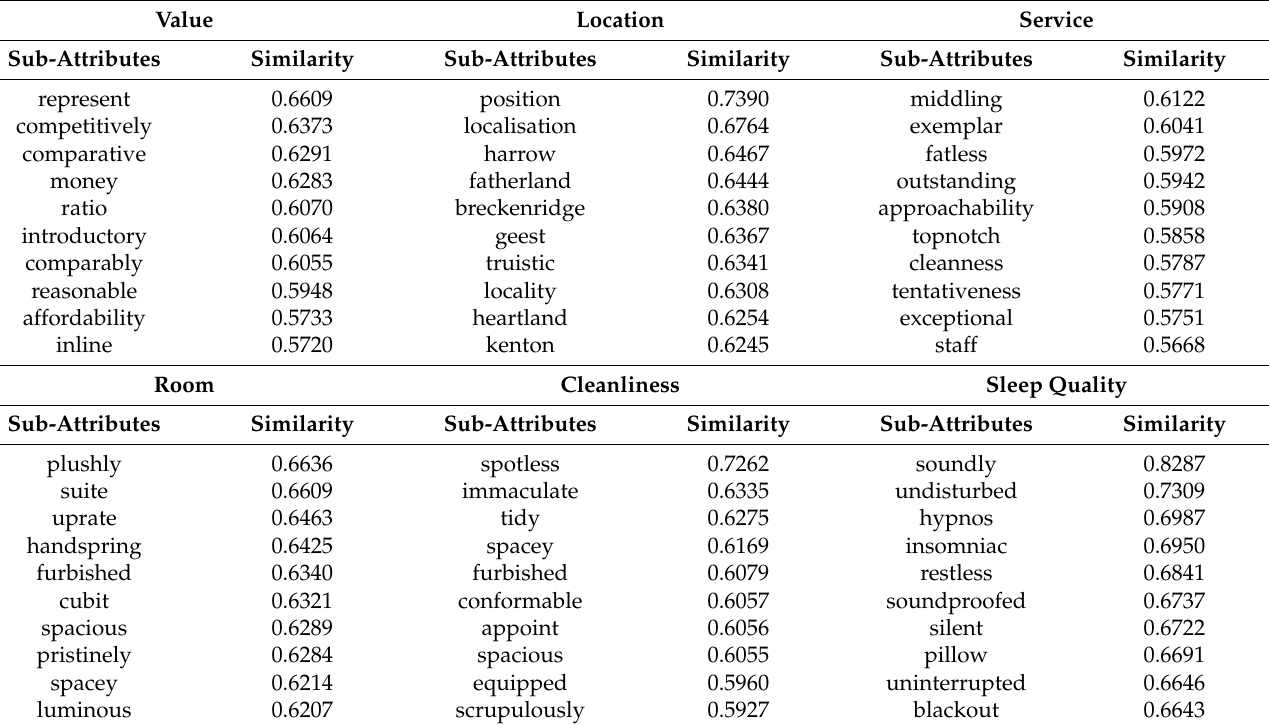
Table 4. Top 10 similar sub-attributes with respect to the six attributes from five-star hotels.